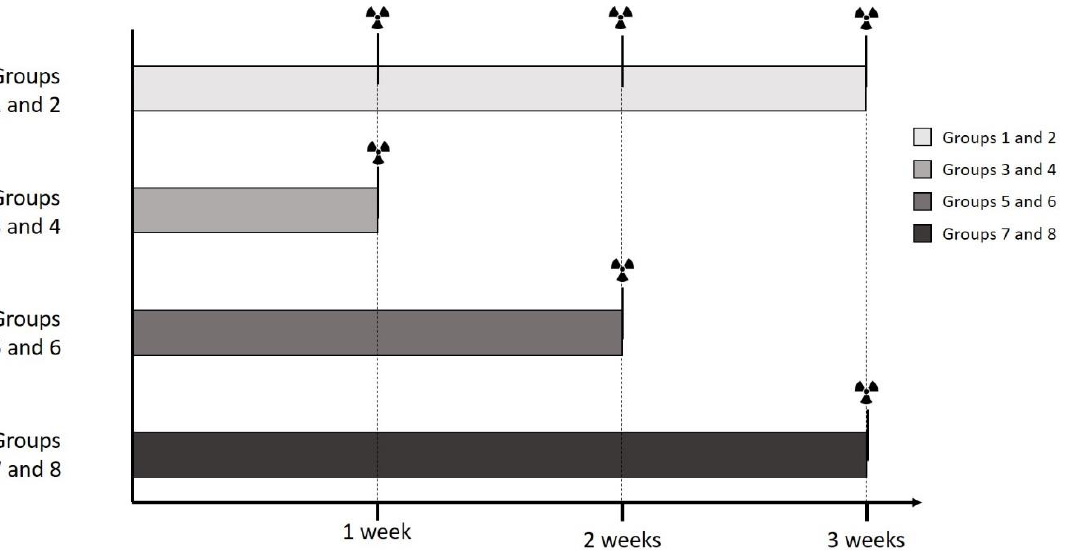
Figure 12. Schematic Overview for Groups 1 to 8 for a better overview of the individual timepoints when the radioactive labeling was performed. ☢ = Timepoint of radioactive labeling